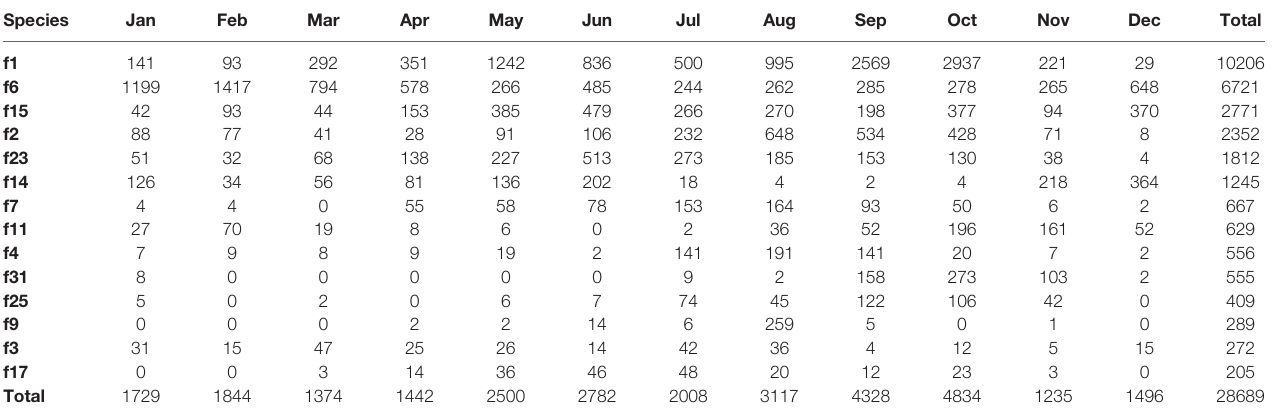
TABLE 2 | The monthly occurrence of fi sh individuals per species and